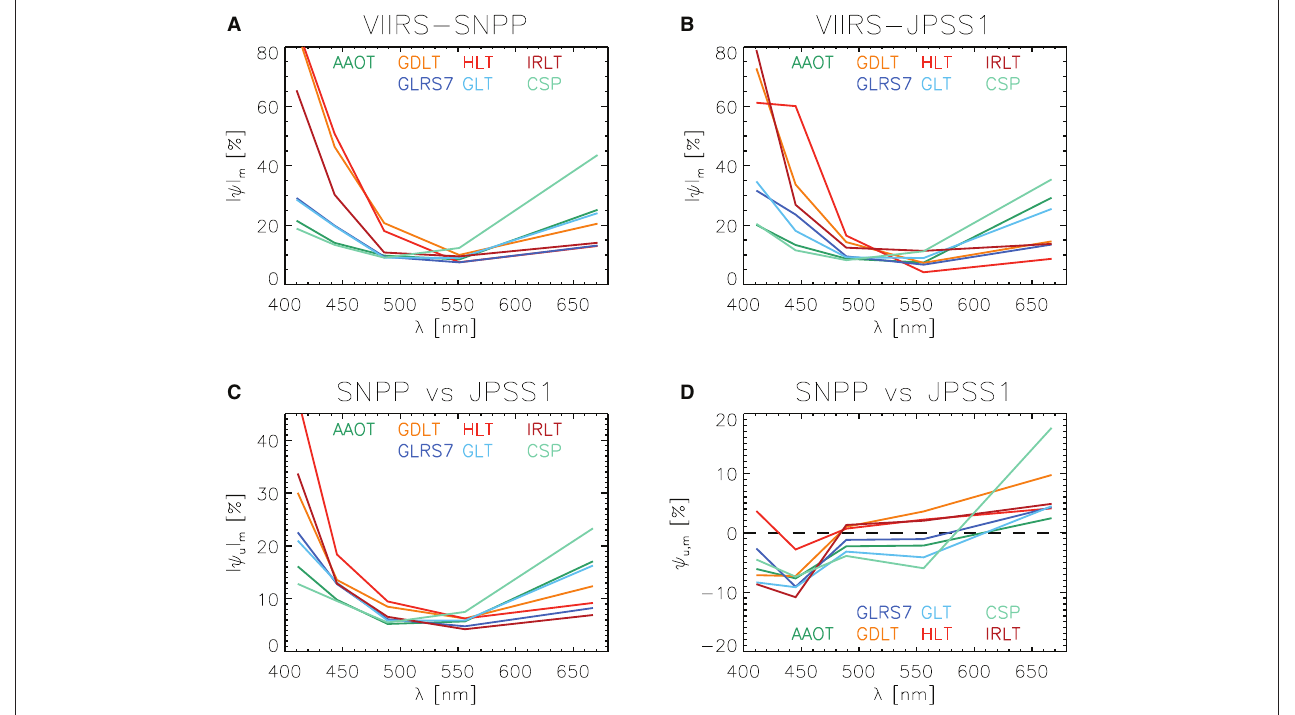
FIGURE 4 | For the various AERONET-OC sites: spectra of median absolute relative difference | ψ | m for (A) the comparison between PRS and VIIRS-SNPP data and for (B) the comparison between PRS and VIIRS-JPSS1; spectra of (C) median unbiased absolute relative difference | ψ u | m and (D) median unbiased relative difference ψ u , m for the comparison between VIIRS-JPSS1 and VIIRS-SNPP